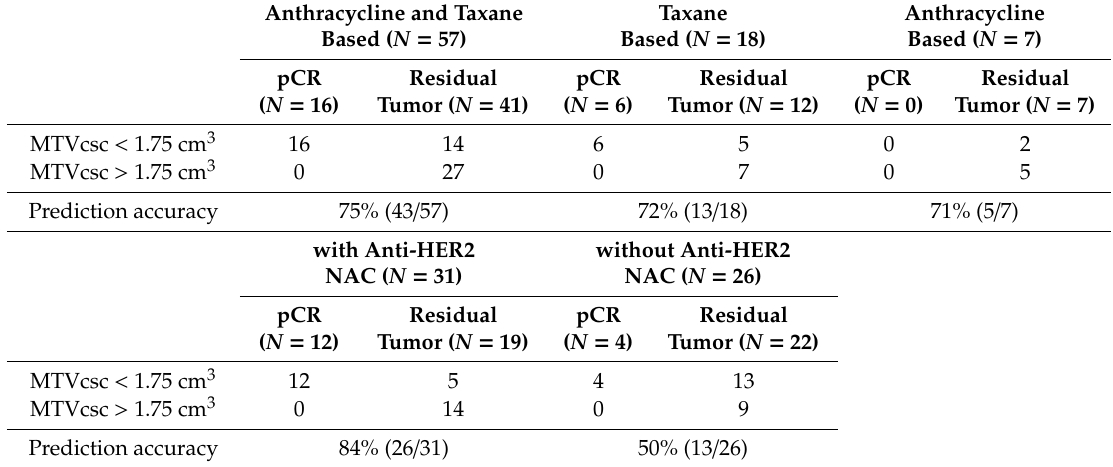
Table 4. Prediction of tumor response to NAC using MTVcsc in HER2-positive and TN subtypes with various NAC regimens.